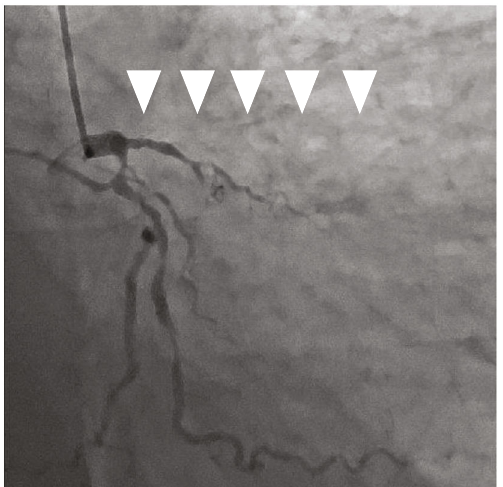
Figure 2: Left anterior descending artery occlusion (arrow) as identi fi ed by CAG. The left circum fl ex artery and high lateral branch of the coronary artery show di ff use stenosis. CAG: coronary